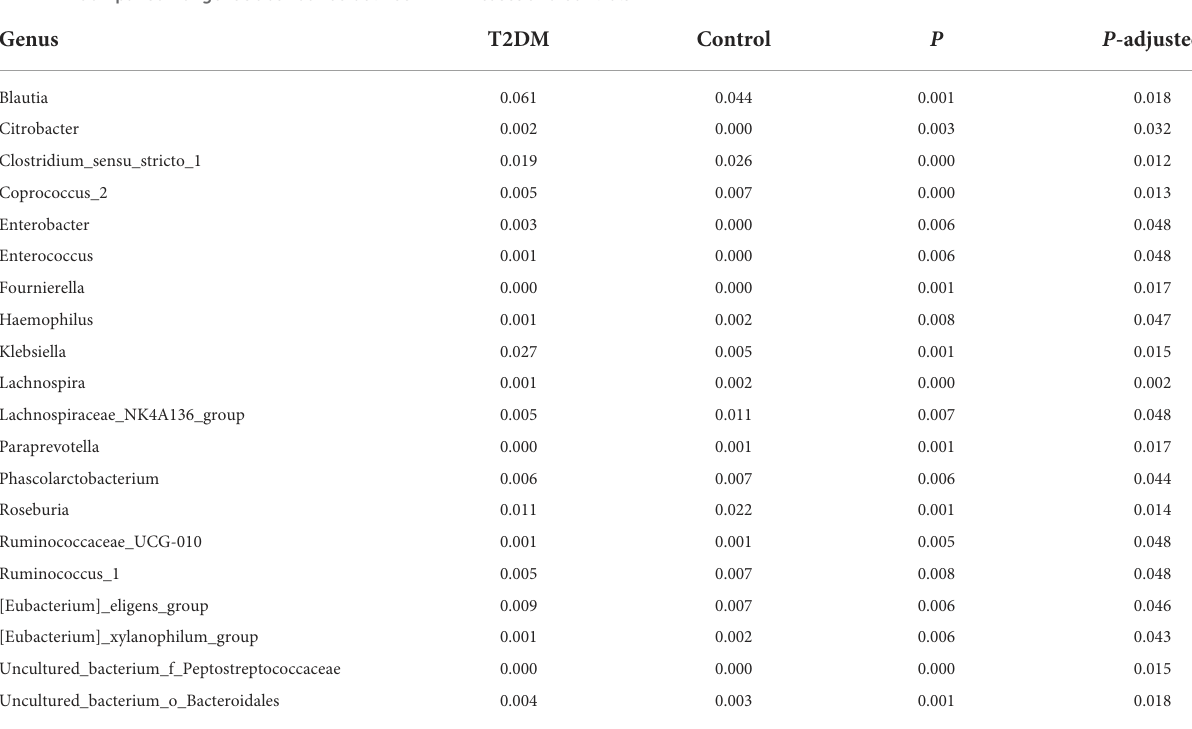
TABLE 2 Comparison of genus abundance between T2DM cases and